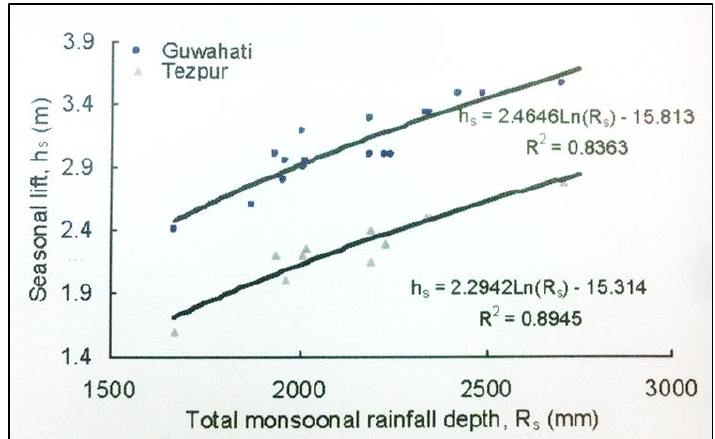
Figure 9. Relationship between the total monsoonal rainfall and monsoonal lift for the gauging stations considered in the study area.